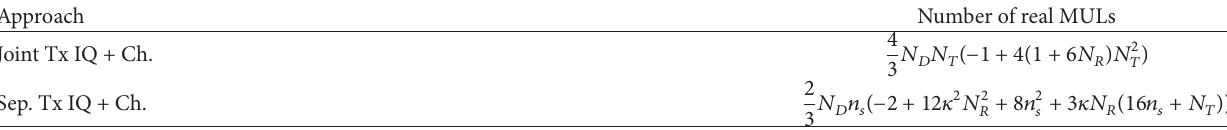
Table 4: Computational complexity expressions for equalization matrix computation. Approach